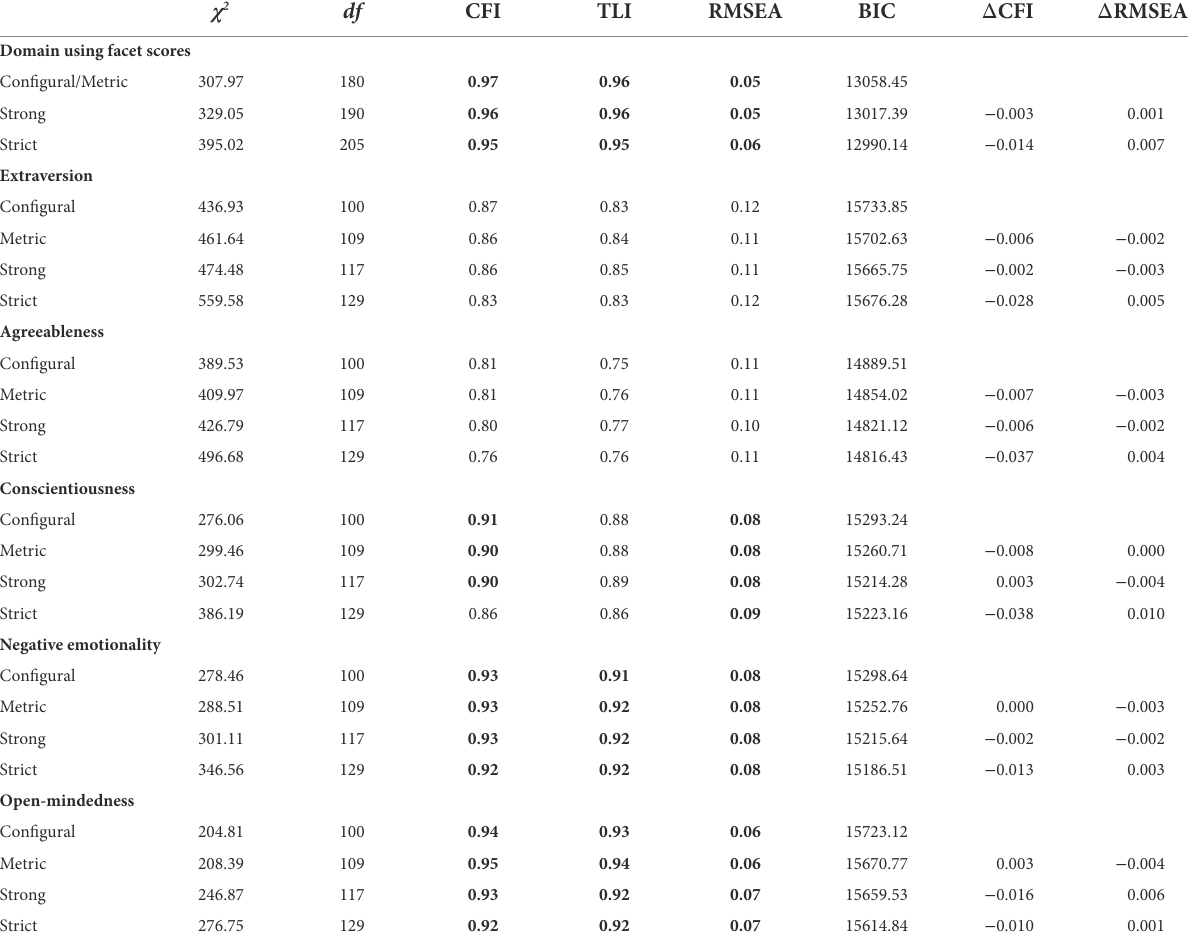
TABLE 7 Fit statistics for measurement invariance analyses at each age